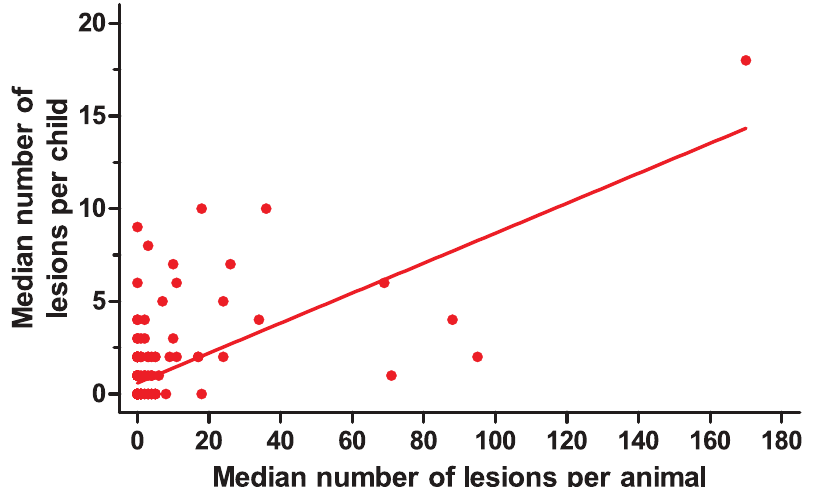
Fig 6. Correlation between the median number of lesions in infected children and infected household animals. The median number of lesion in children 3 – 8 years old on one randomly selected foot was plotted against the median number of lesions in animals from the same household (rho = 0.47, p <